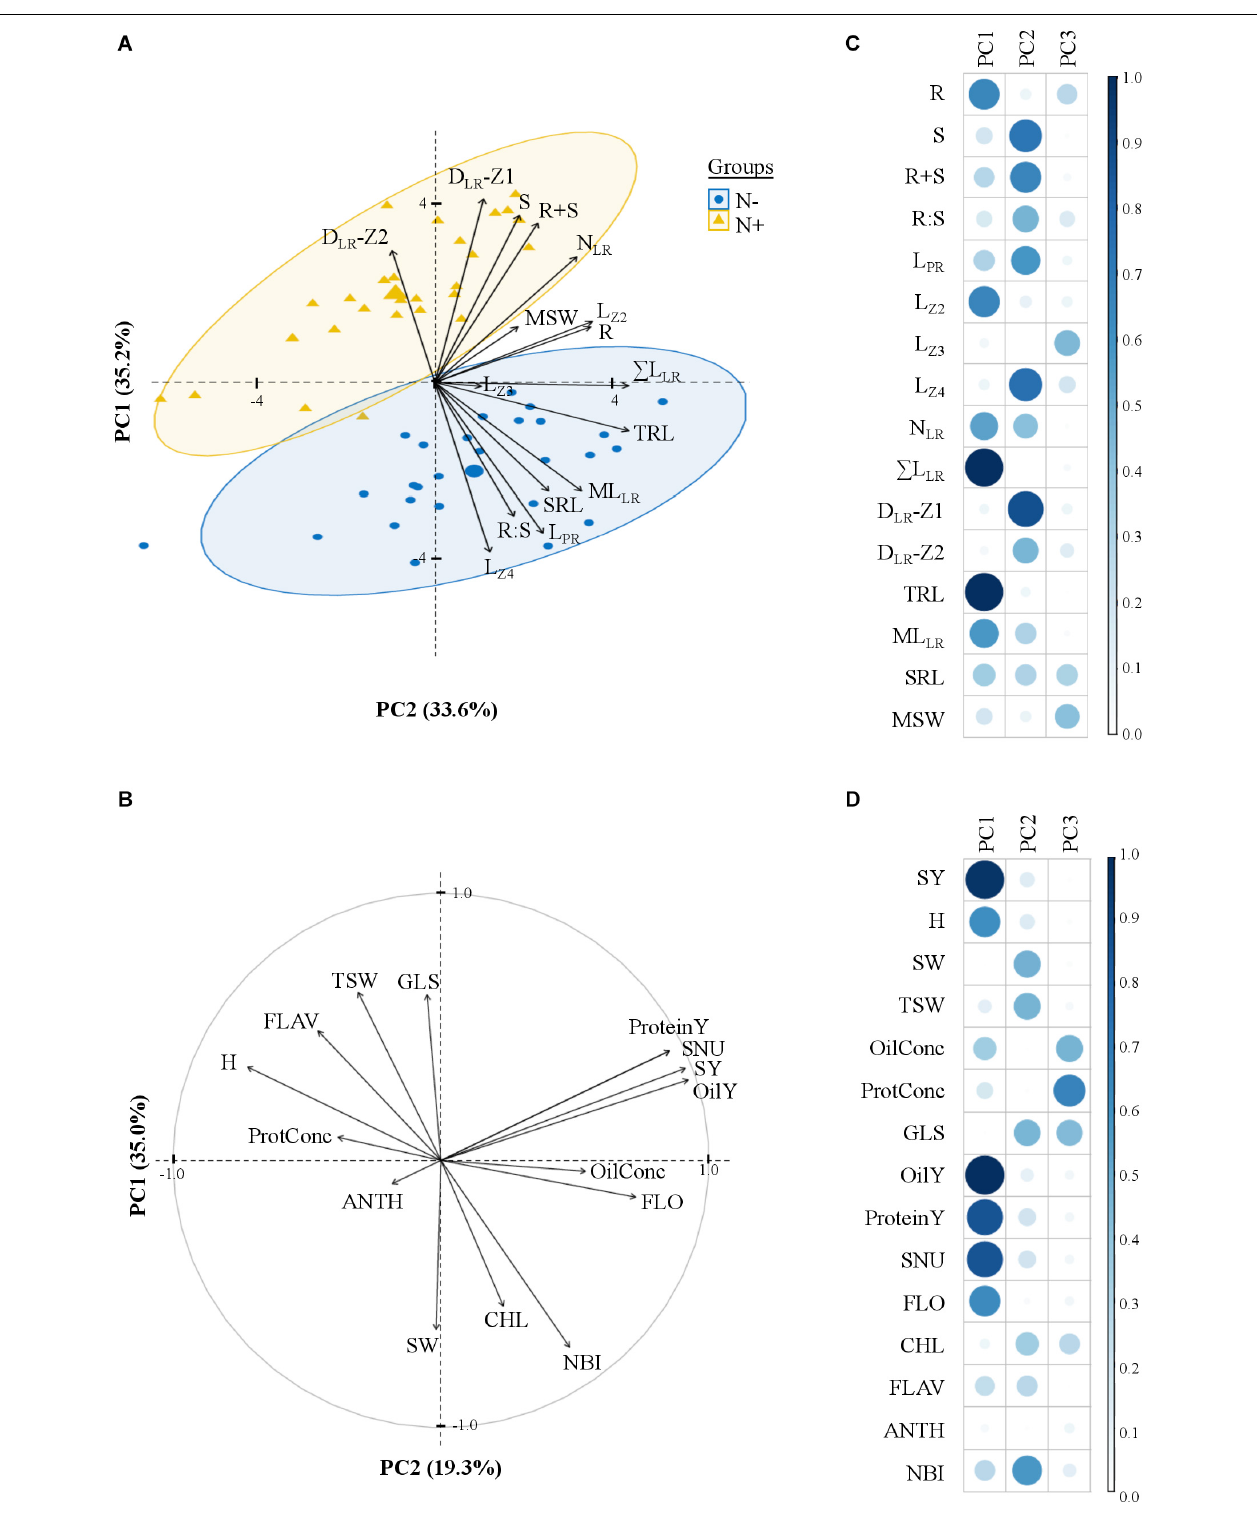
FIGURE 4 | Principal component analysis of traits measured in laboratory and field environments. The biplot graph (A) shows 16 variables and 28 cultivars grown in laboratory environment with 5.0 mM (N+) or 0.2 mM (N–) nitrate supplies and the correlation circle (B) 15 variables in field environment, with the two first dimensions. Percentages under brackets are those contributed by the first and second principal components. (C,D) Representation quality of the variables on the dimensions (values = squared cosines). Traits are defined in Tables 1 , 2 .